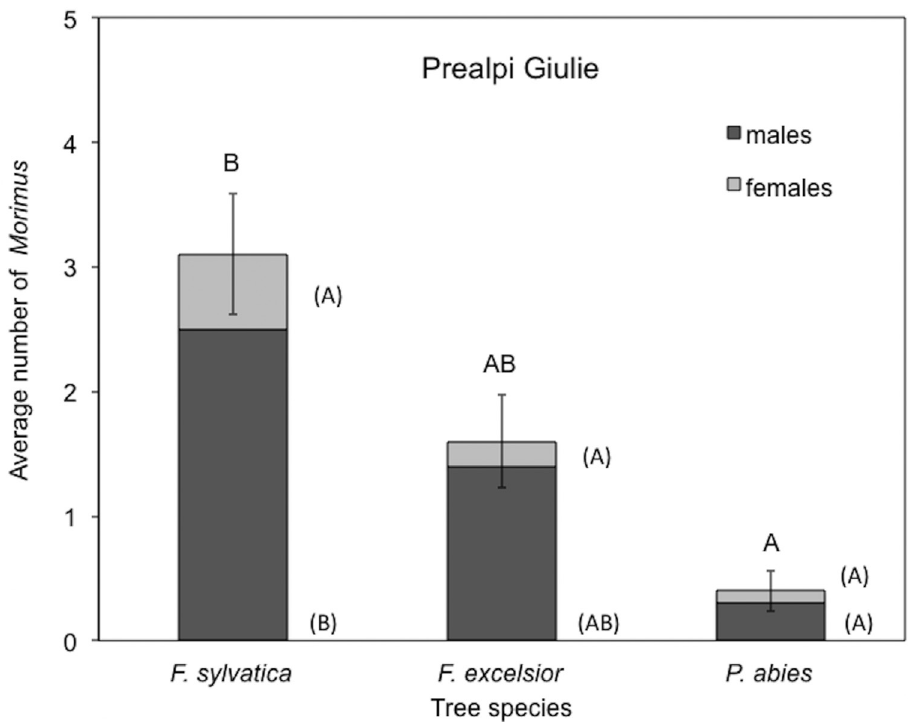
Figure 3. Prealpi Giulie. Average number (±SE) of adults of M. asper observed per sampling on the seven wood piles built from wood of different tree species. Different capital letters above columns (total adults) and on the right (males and females) indicate significant differences among wood types at the 0.01 level (Dunn’s Multiple Comparisons